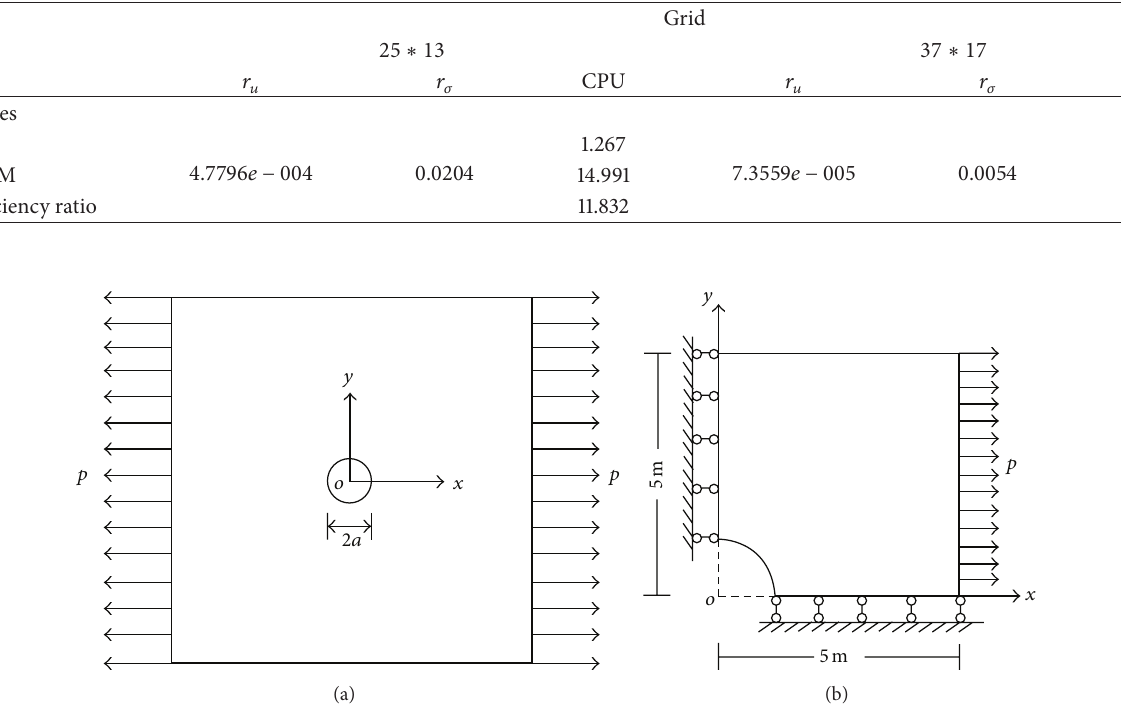
Table 7: Effect of the size of support domain for the RG method (Example 4.2 ).